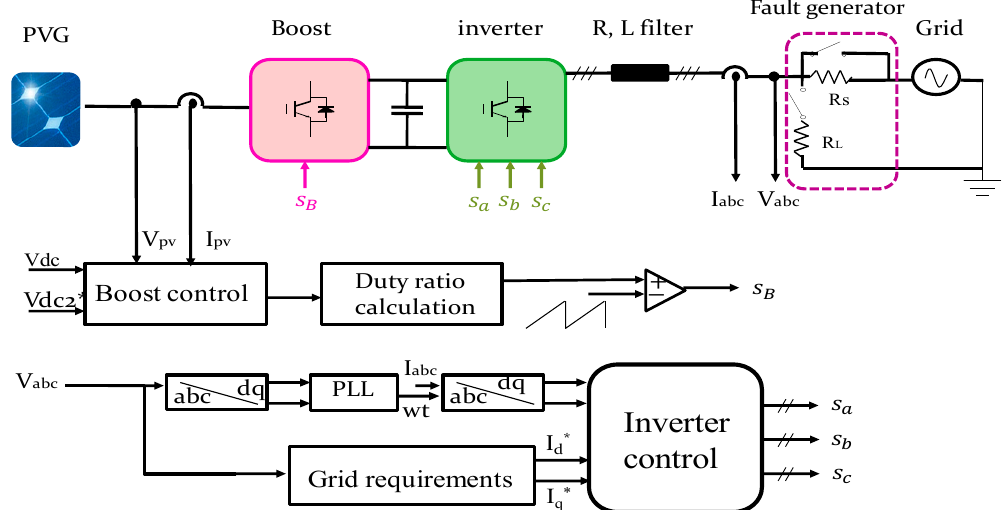
Figure 3. The control diagram of the PV connected system.